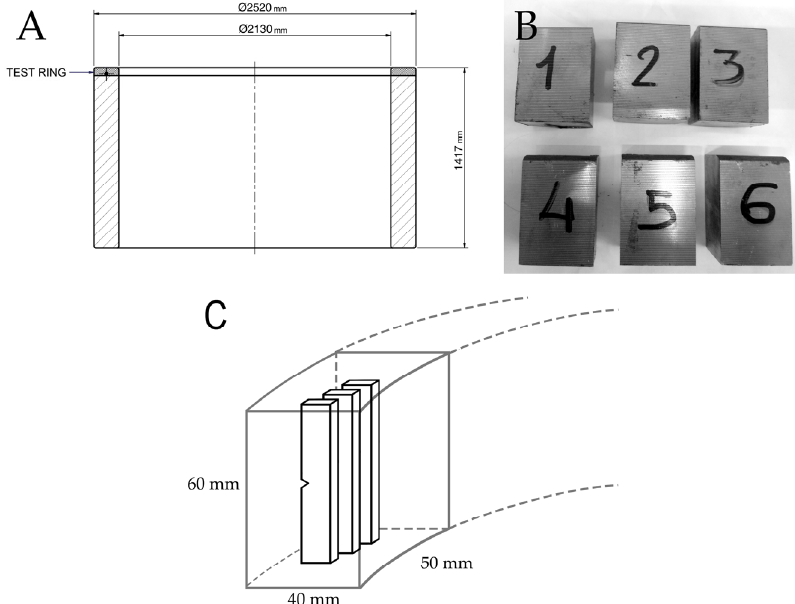
Figure 1. Drawing of the forging bush and of the position of the test ring ( A ); test ring sections used for the laboratory scale heat treatments ( B ); sketch of the extraction of the Charpy specimens from the test ring ( C ). Table 1. Composition of the S690 steel (wt.%).